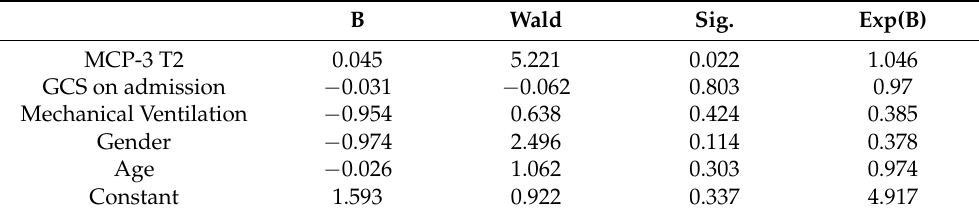
Table 6. Binary logistic regression model of independent predictors of DCI status after aSAH. B Wald Sig.